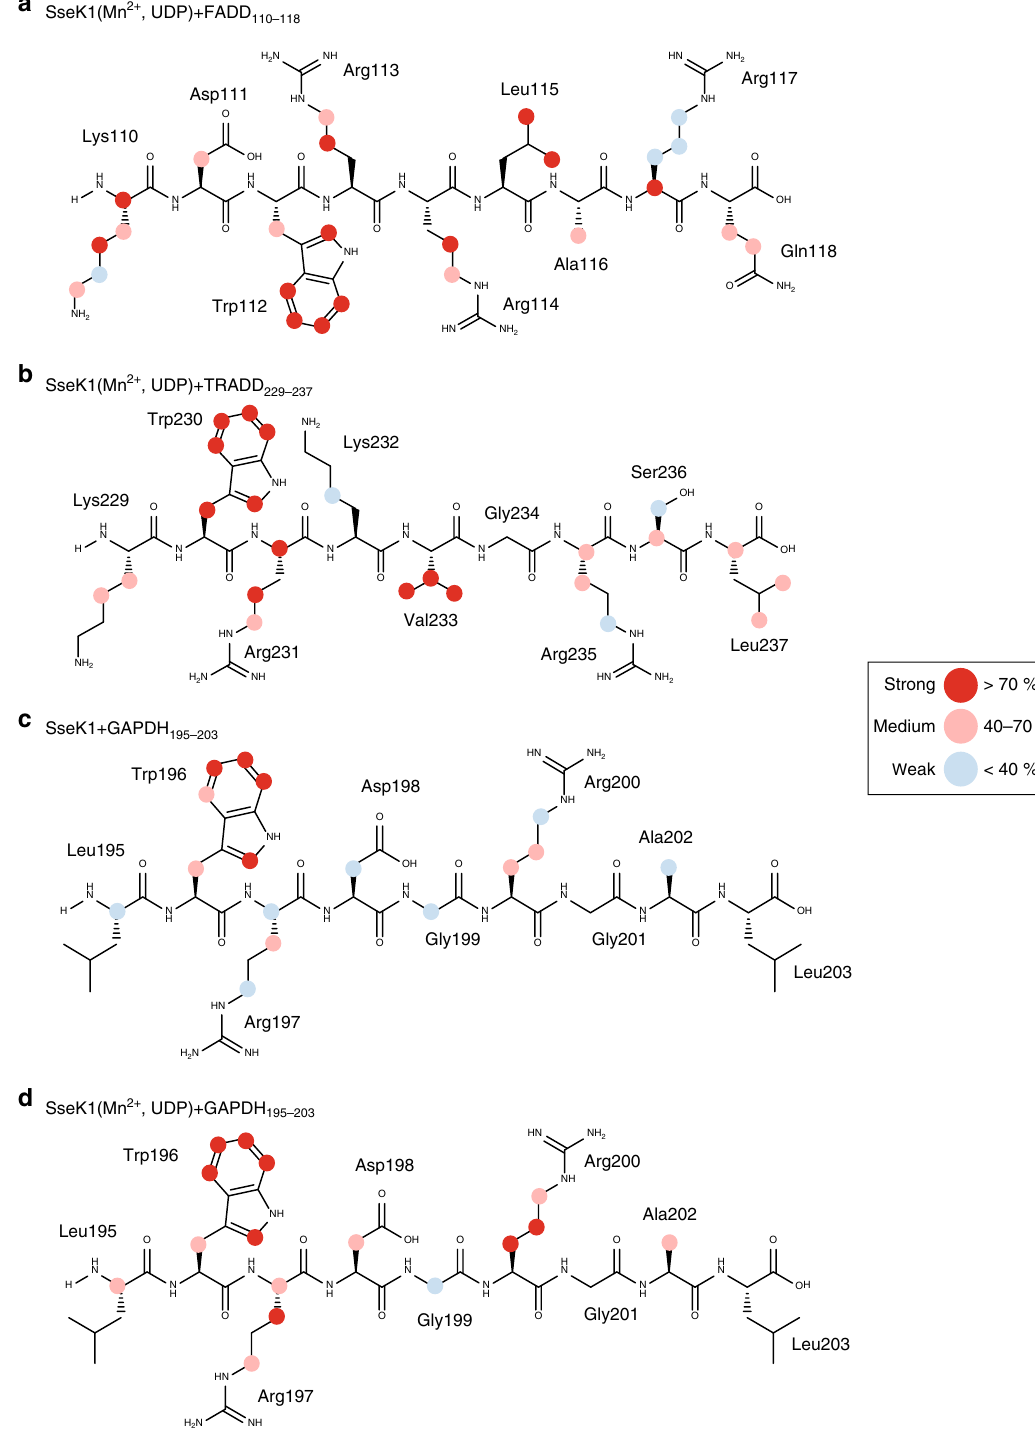
Fig. 5 Binding modes of short peptide substrates. Binding epitope mappings of a FADD 110-118 b TRADD 229-237 and c , d GAPDH 195-203 peptides in the presence of 25 μ M SseK1. Samples in a , b and d contained 25 μ M Mn 2 + , and 25 μ M UDP. All STD intensities normalized against H ζ 2 of the tryptophan. Colored circles represent magnitude of normalized intensities (blue:< 40%, pink: 40 – 70%, red:> 70%). Comparison of GAPDH 195 – 203 binding to SseK1, c in the absence, and, d in the presence of Mn 2 + and UDP, reveals a signi fi cant change in the binding mode of the substrate peptide upon addition of the cofactor and the nucleotide diphosphate. For STD NMR study of binding to SseK2 see Supplementary Fig.